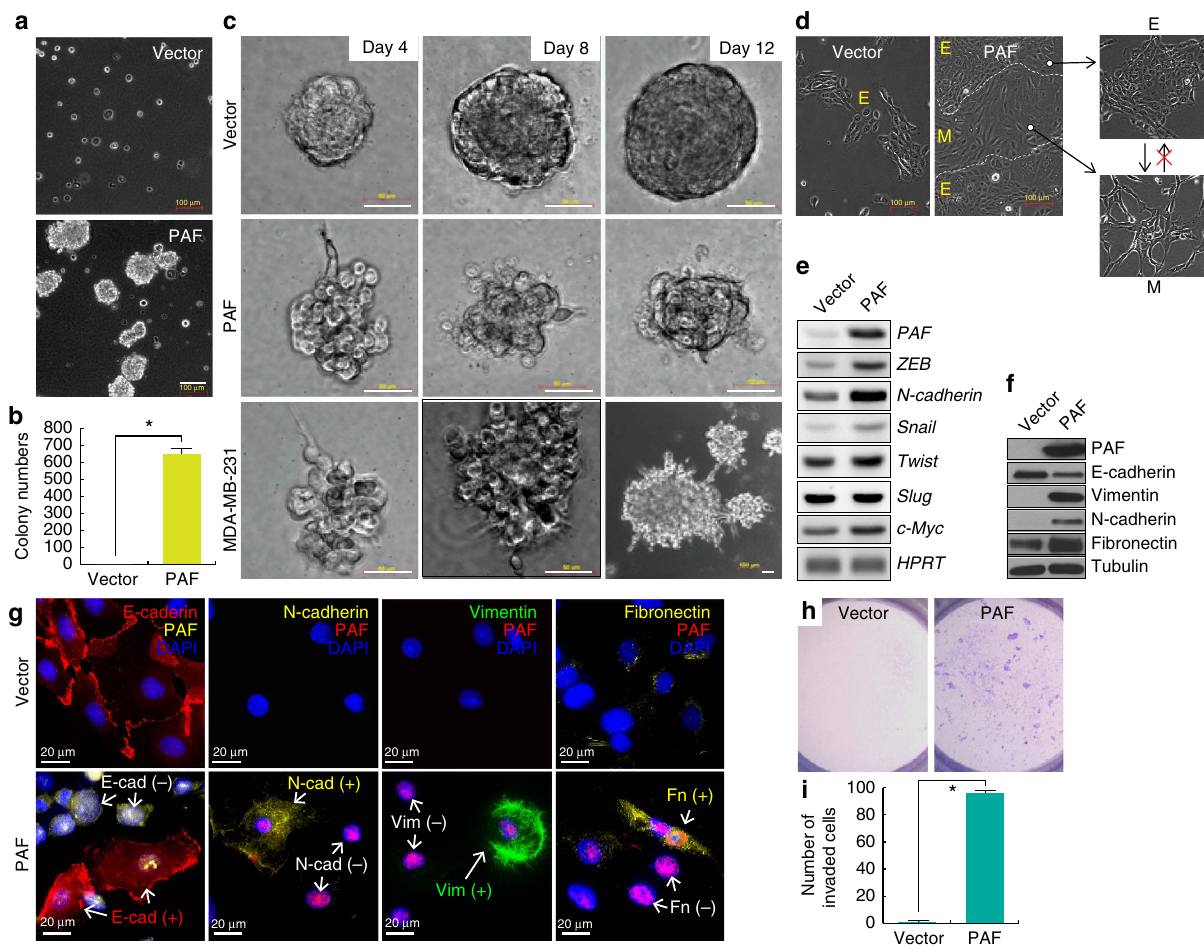
Figure 2 | In vitro tumorigenic function of PAF. ( a , b ) Anchorage-independent growth of PAF-expressing MECs. Soft agar clonogenic assays were performed using 76NF2V-vector (control) or -PAF MECs. Each group of cells was grown in semisolid matrices (soft agar) for 3 weeks and analysed. ( a ) Phase-contrast images. ( b ) The number of colonies was quantified using colony counting. Student’s t -test; error bars ¼ s.e.m. Scale bars, 100 m m. ( c ) PAF-induced transformation of MECs. 76NF2V-vector, -PAF and MDA-MB-231 cells were cultured in three-dimensional Matrigel. Phase-contrast images of spheroid formation of each group of cells. MBA-MB-231 cells served as a positive control. Scale bars, 50 m m. ( d ) EMT by PAF. By light trypsinization, epithelial cell-like cells ( e ) and mesenchymal cell-like cells ( m ) were separated and cultured subsequently. It is noteworthy that e cells generate m cells but not vice versa . Scale bars, 100 m m. ( e – g ) Upregulation of EMT-related genes. 76NF2Vcells (vector versus PAF) were analysed for reverse transcriptase–PCR (RT–PCR) ( e ), IB ( f ) and immunofluorescent staining ( g ). Scale bars, 20 m m. ( h , i ) Increased cell invasion by PAF. 76NF2V cells (vector versus PAF) were analysed for cell invasion assays. Images of cell migration ( h ); quantitative analysis ( i ). Student’s t- test; error bars ¼ s.e.m. * P o 0.05; N 4 3. NATURE COMMUNICATIONS|7:10633|DOI: